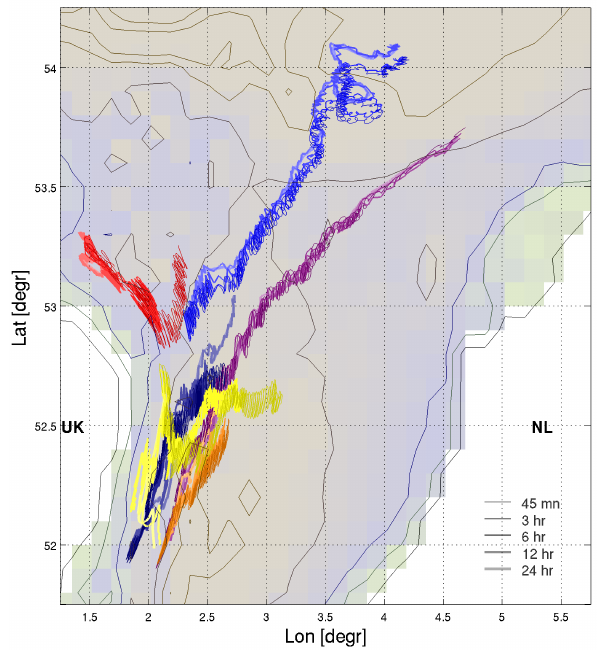
Figure 18. The effect of altering the hydrodynamic forcing time step on the particle drift paths, reproducing the drifting buoys (dis- cussed in Sect. 3.1). In the particle tracking routine, the hydrody- namics were updated every 45min, every 3 6 12 and 24h. These update intervals are shown in the thickness and darkness of the lines, while the colour of the lines correspond to the different drifter buoys (as presented in Fig.